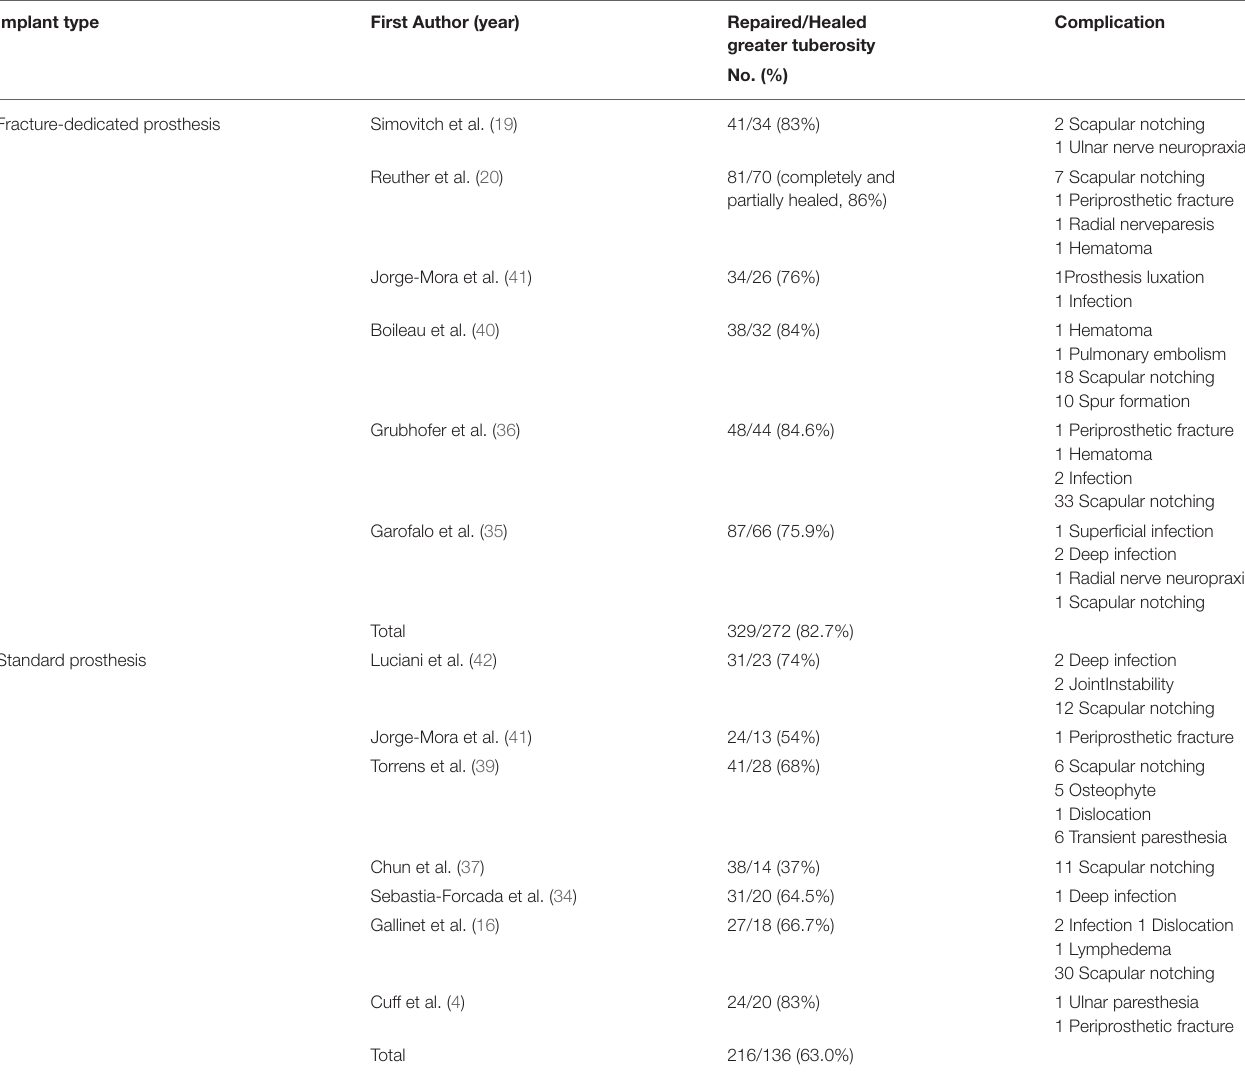
TABLE 4 | Summary of healing rates of greater tuberosity and complications between the fracture-dedicated prosthesis and the standard prosthesis. Implant